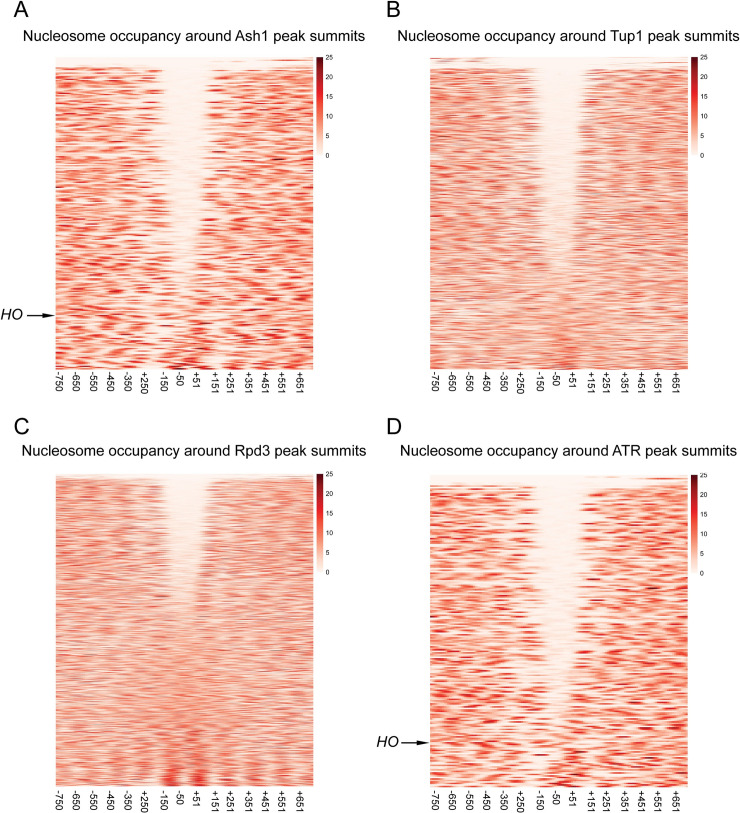
Sites of Ash1, Tup1, and Rpd3 co-enrichment are found within nucleosome depleted regions (NDRs).The MNase-Seq data was used to estimate the dyad position for each nucleosome, and this information was used to create a pileup of MNase-generated fragments, with each line representing a single gene. MNase-Seq heat maps are shown depicting the nucleosome occupancy surrounding the peaks for factor binding, displaying density from -750 to +750 nucleotides relative to the center of each peak, in bins of 20-bp. The color scale at the right indicates the level of nucleosome occupancy (fragments per million). (A) Each horizontal line depicts a single Ash1-V5 peak, of 246 total peaks, with the HO peak indicated. The number of peaks is less than that reported in Fig 4A because only the strongest peak per intergenic region was used for the analysis. (B) Each horizontal line depicts a single Tup1-V5 peak, of 816 total peaks. (C) Each horizontal line depicts a single Rpd3-V5 peak, of 1343 total peaks. (D) Each horizontal line depicts a single peak of co-enrichment of Ash1-V5, Tup1-V5 and Rpd3-V5, of 209 total peaks, with the HO peak indicated.